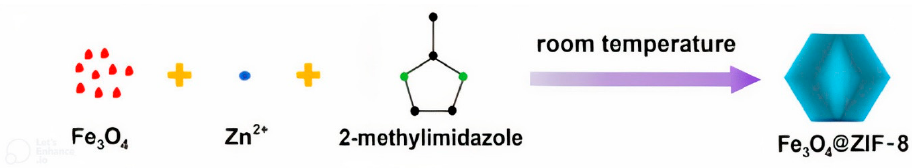
Figure 6. Process of Fe 3 O 4 @ZIF-8 synthesis, reproduced with permission from [163]. Copyright Elsevier, 2019. Elsevier,